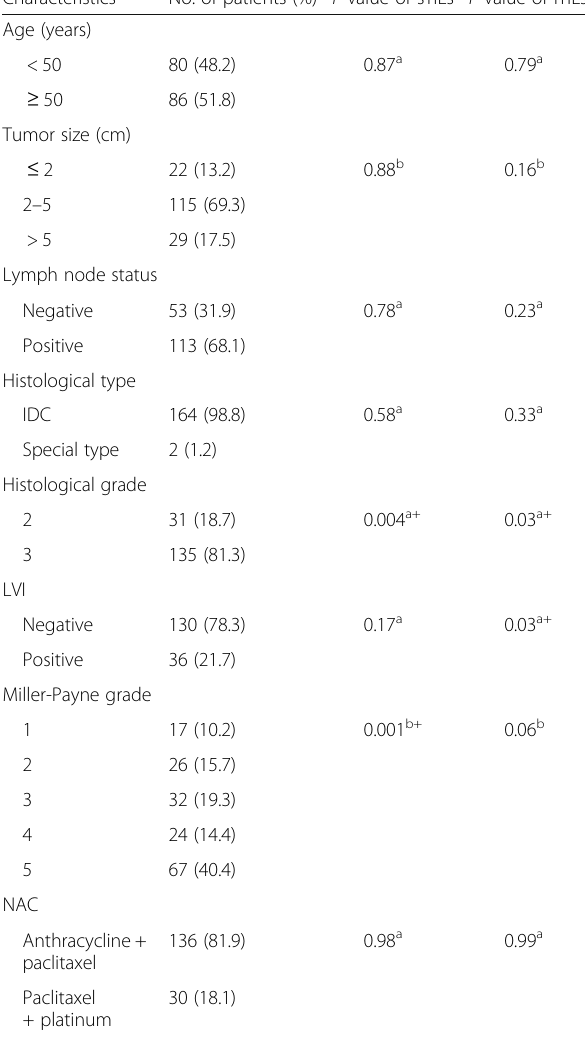
Table 1 Correlations between TILs and clinicopathologic characteristics in TNBCs Characteristics